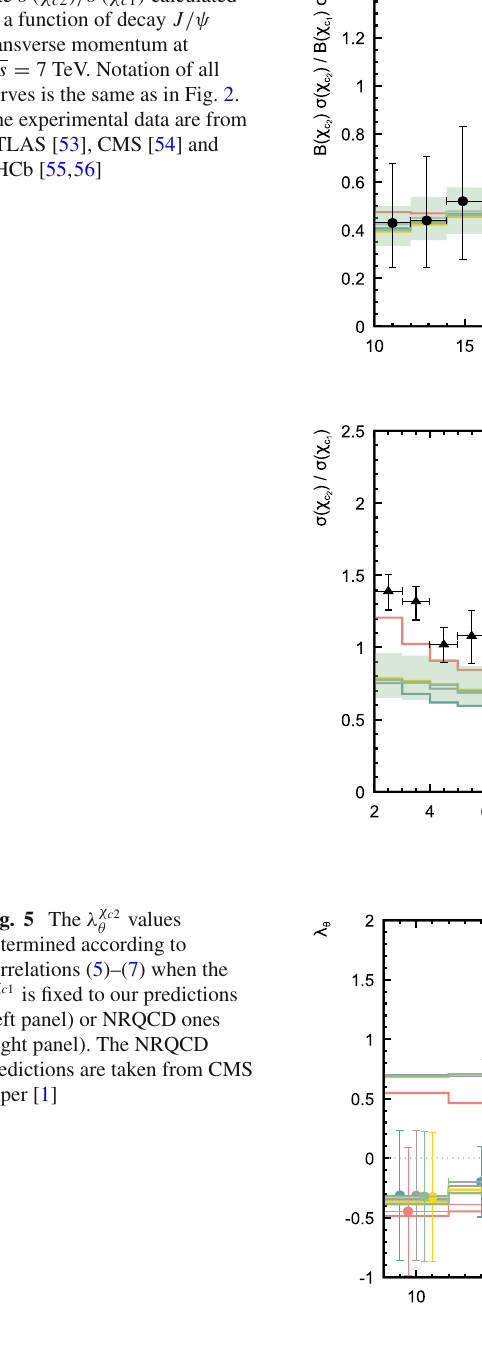
Fig. 4 The relative production rate σ(χ c 2 )/σ(χ c 1 ) calculated as a function of decay J /ψ transverse momentum at √ s = 7 TeV. Notation of all curves is the same as in Fig. 2. The experimental data are from ATLAS [53], CMS [54] and LHCb [55,56]